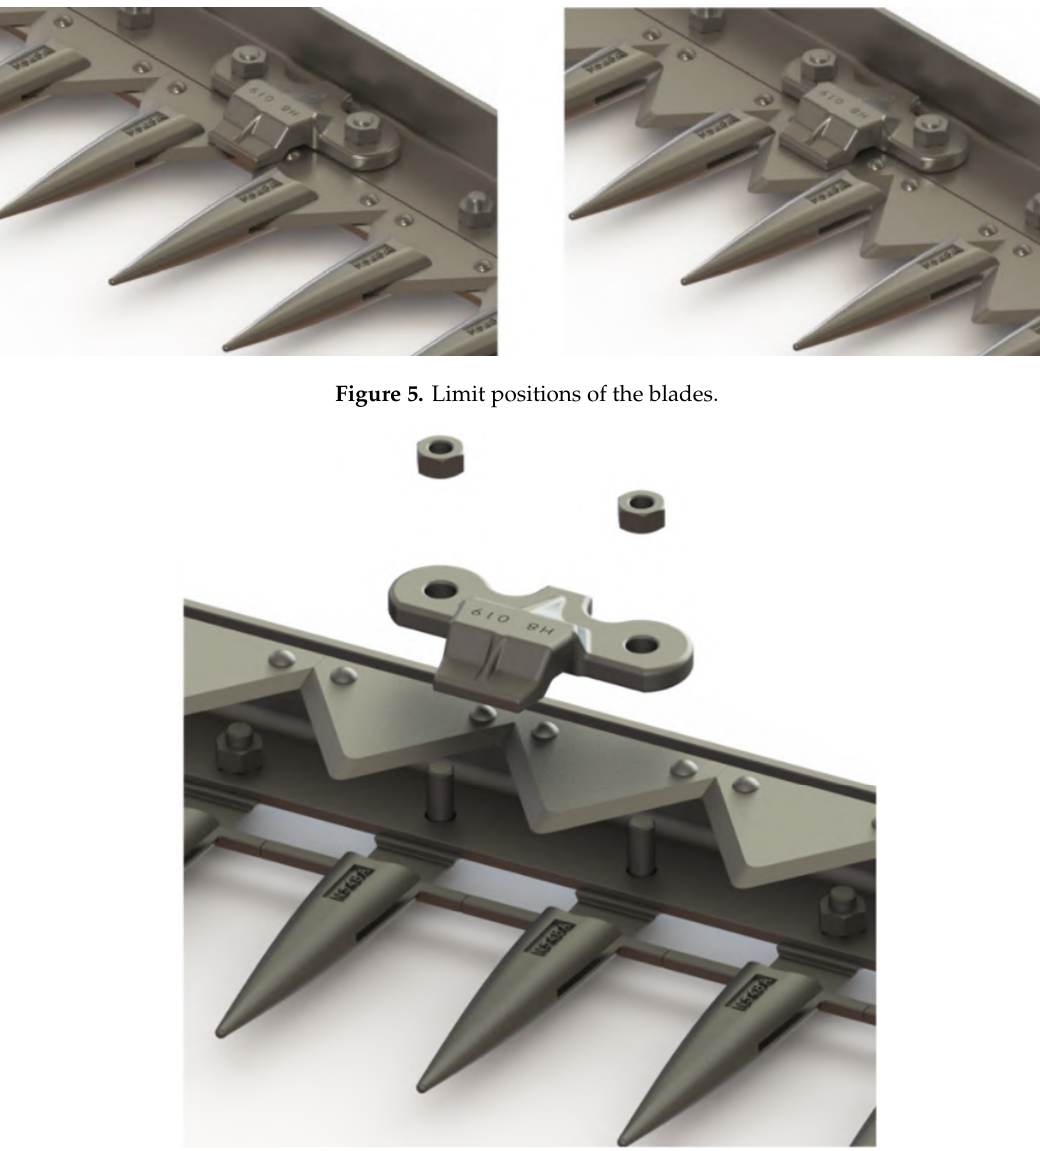
Figure 6. Exploded view of the cutting system.